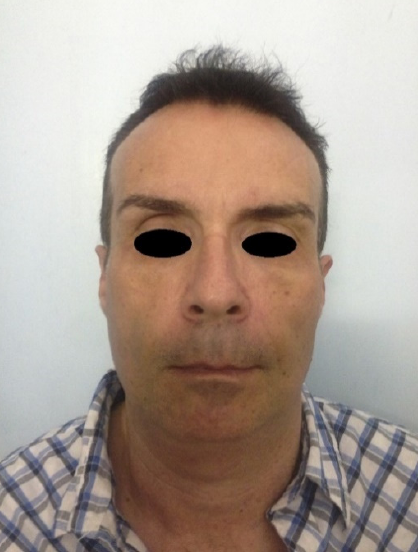
Figure 6. Frontal view of a patient presenting facial wasting and submental fullness (the same patient shown in Figure 4) treated with CaHA and DCA injection, at 8 months and 3 months fol- low-up respectively.